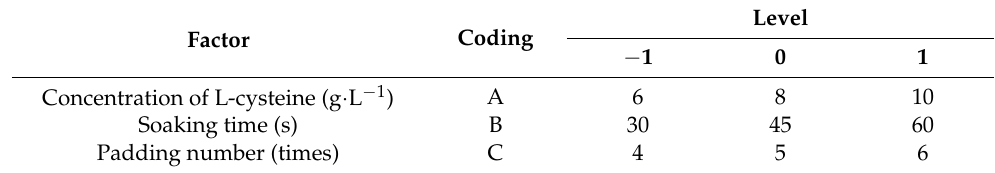
Table 6. Process variables and experimental